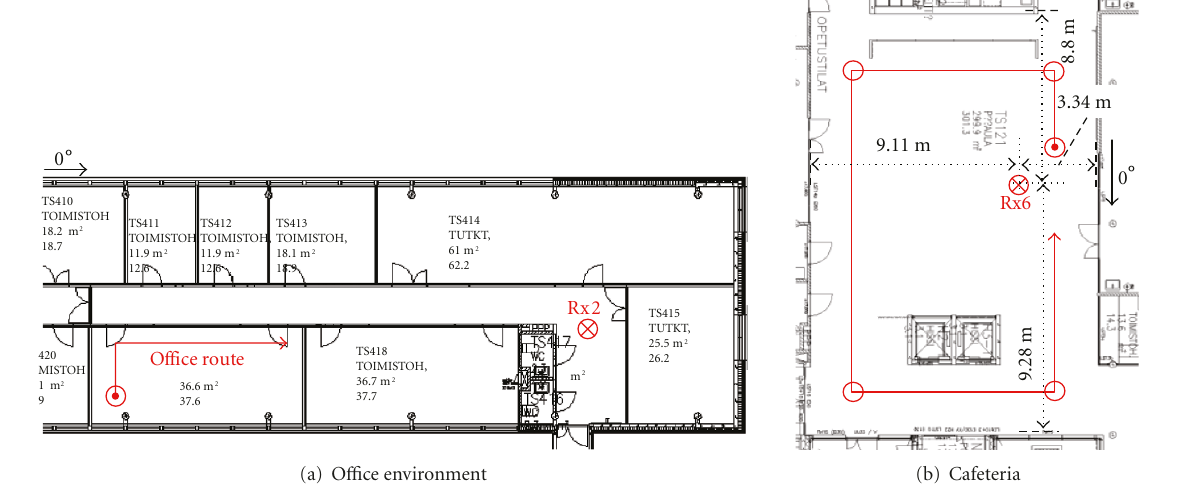
Figure 11: Measured scenarios.